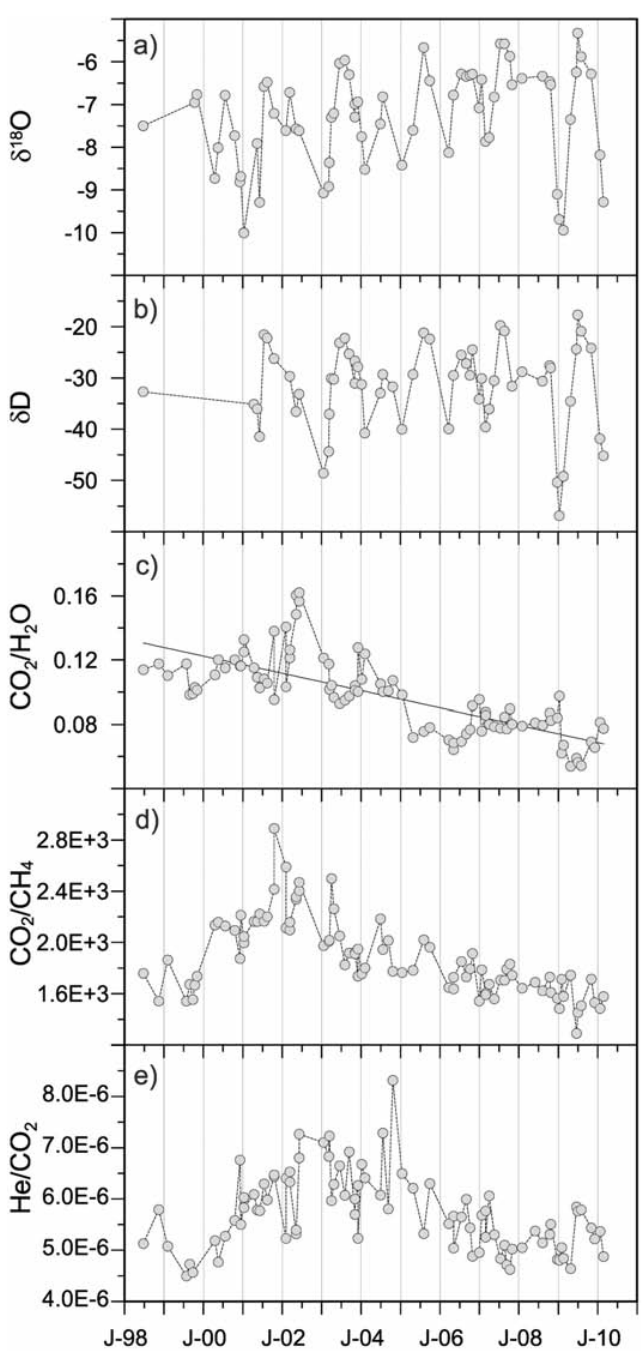
Figure 4. Time-series of selected parameters: a) d 18 O